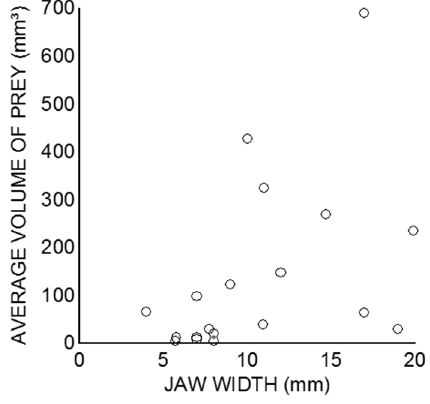
Figure 1 - Specialization diagram of Haddadus binotatus population from an Atlantic Rainforest area in the state of Espirito Santo, southeastern Brazil. The Y axis (Pi) shows the proportion of the prey item only for the individuals that consume it. The X axis shows the frequency of occurrence of the prey items in the diet. Each letter inside the diagram repre- sents one prey type (A = Acari; B = Araneae; C = Blattodea; D = Chilopoda; E = Coleoptera; J = Hemiptera; K = Homoptera; L = Isopoda; N = Lepidoptera; O = Mantodea; P = Opiliones; Q = Orthoptera; S = Pseudoscorpiones; T = Thysanoptera).